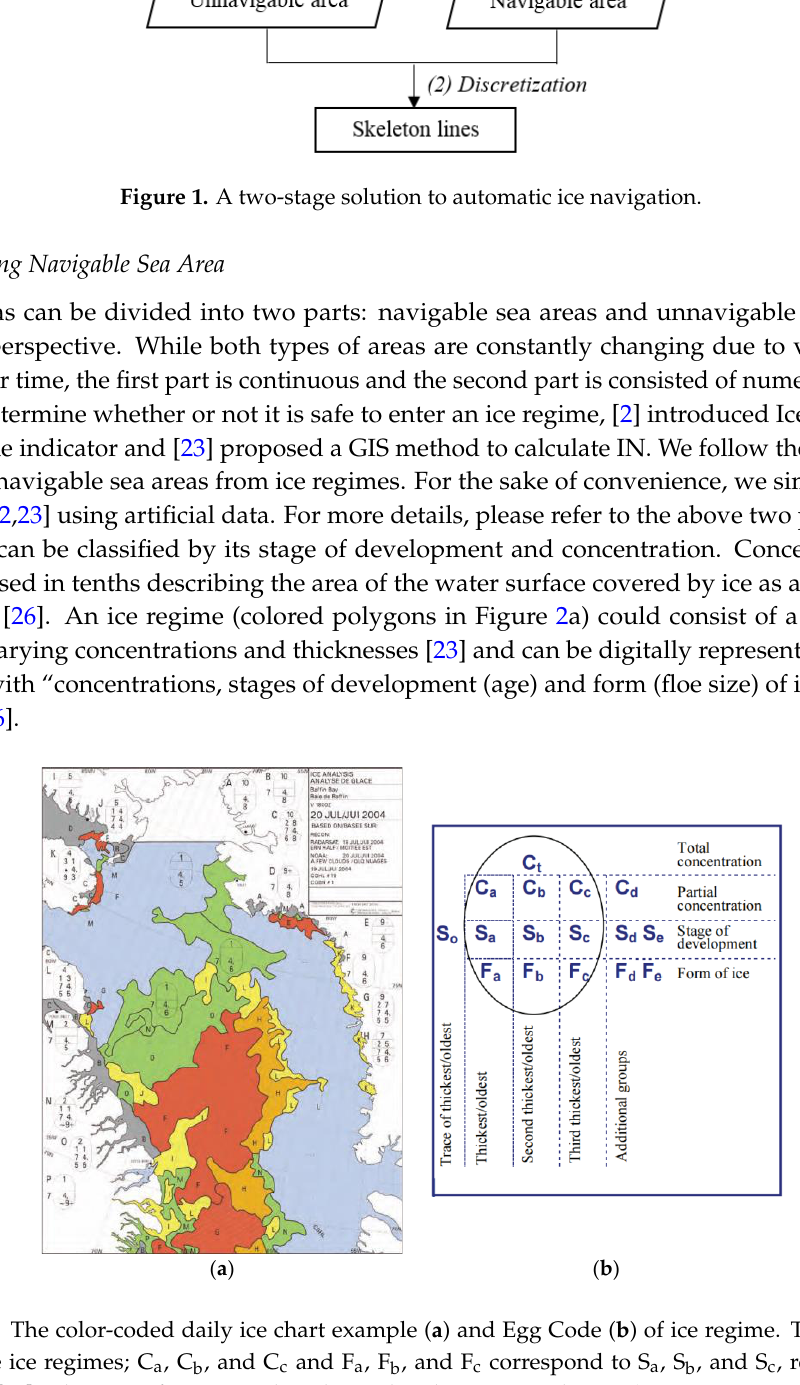
Figure 2. The color-coded daily ice chart example ( a ) and Egg Code ( b ) of ice regime. The